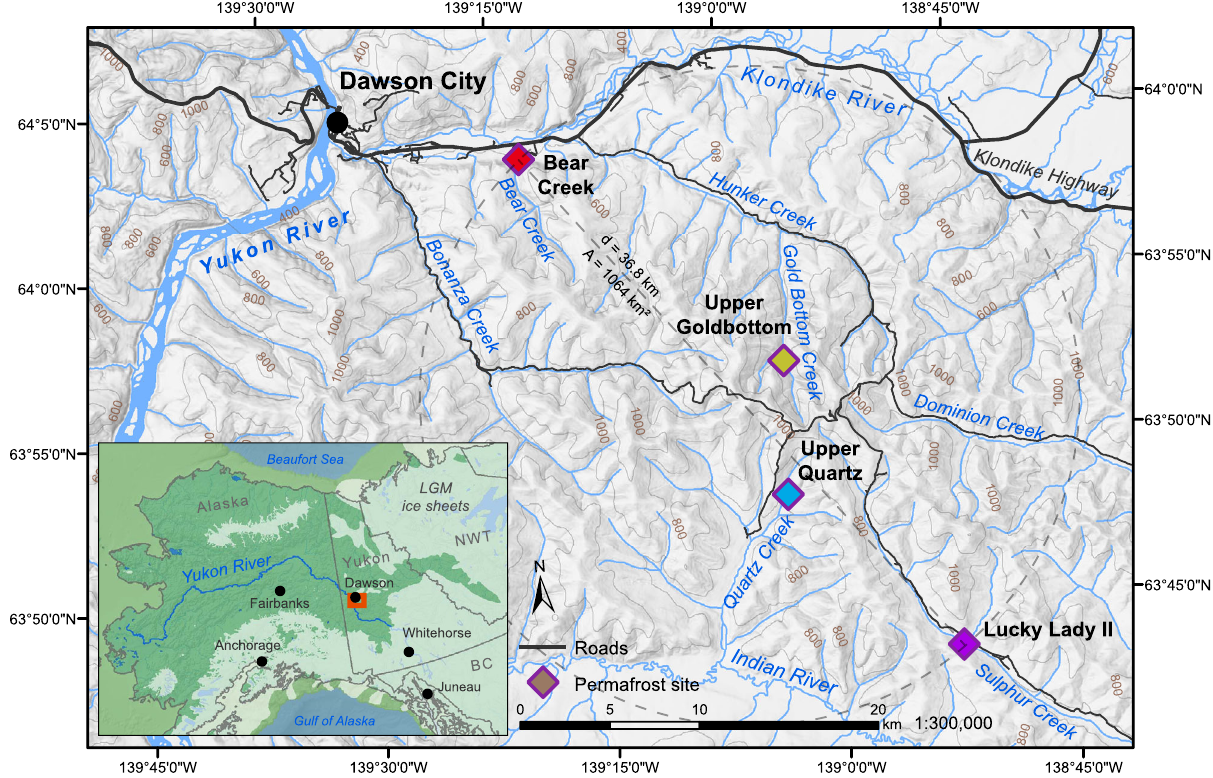
Fig. 1 Permafrost sites from the Klondike region of Yukon, Canada. Base map data retrieved from GeoYukon (hosted by the Government of Yukon); contours elevation unit: meters above sea level. See Supplementary Fig. 2 for a description of inset map data